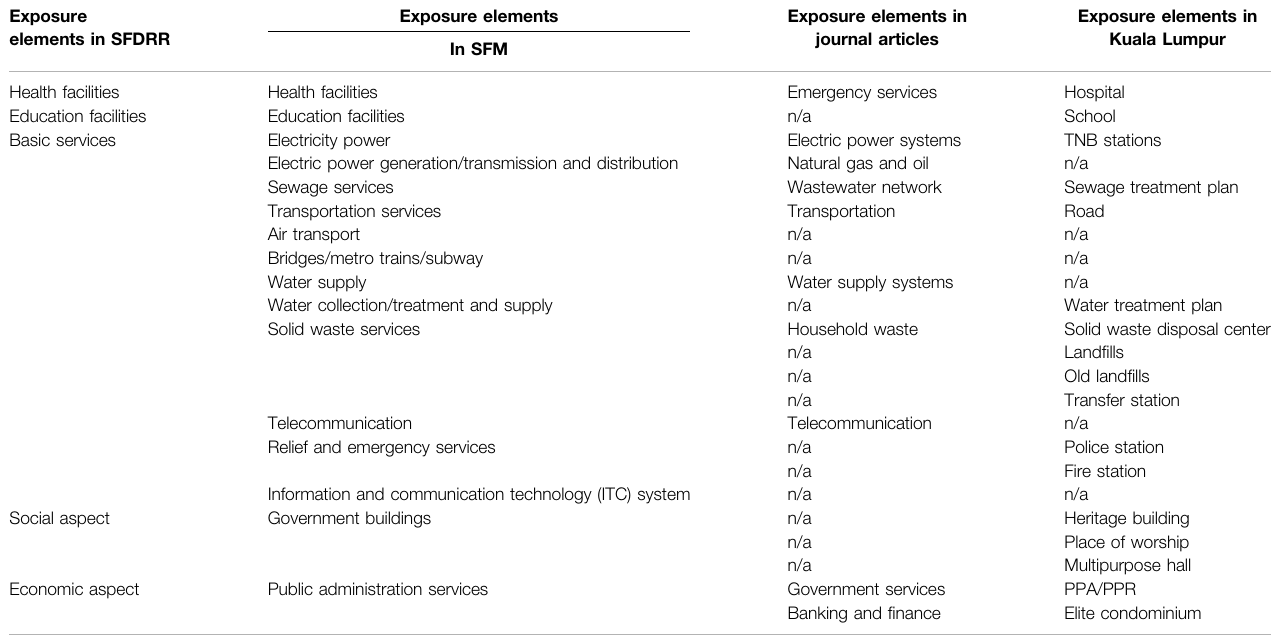
TABLE 1 | Exposure elements organized into the fi ve major categories of SFDRR (Target D). Exposure elements in